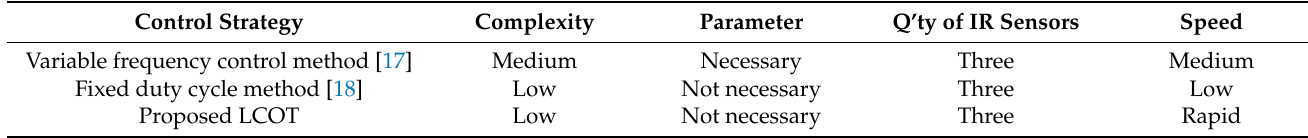
Table 1. Comparison of three control